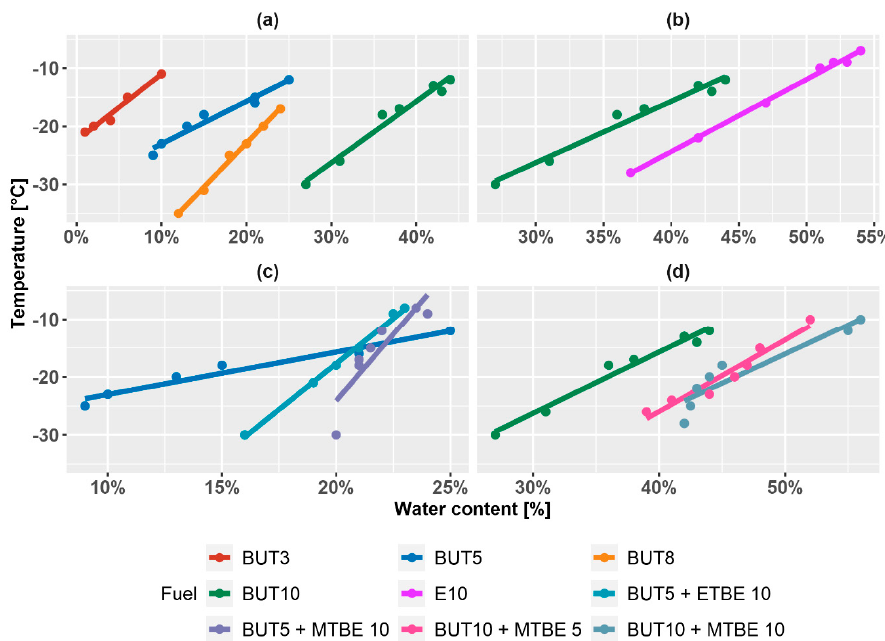
Figure 7. The solubility of water in alcohol-gasoline blends expressed as the temperature of crystallization. ( a ) Comparison of butanol-gasoline mixture with increasing volume of butanol in mixture; ( b ) comparison of 10% (V/V) n–butanol and 10% (V/V) ethanol; ( c ) comparison of 5% (V/V) n–butanol with addition of 10% (V/V) MTBE and 10% (V/V) ETBE; ( d ) comparison of 10% (V/V) n-butanol with the addition of 5% (V/V) MTBE and 10% (V/V) MTBE.